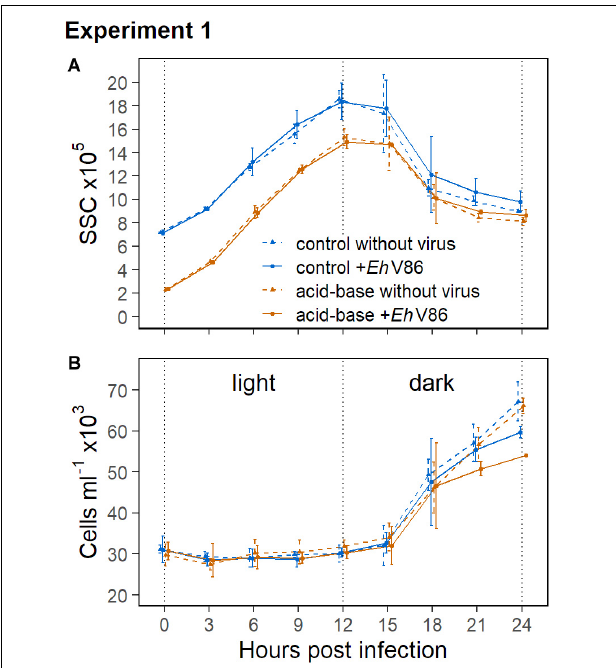
FIGURE 3 | Results of the calcifying E. huxleyi (CCMP1516) within the first 24 h of Experiment 1. Decalcified cells scatter less light (SSC) than calcified cells (A) . The SSC increased during the light period and cell division took place in the dark (B) . Mean ± 1 SD ( n =